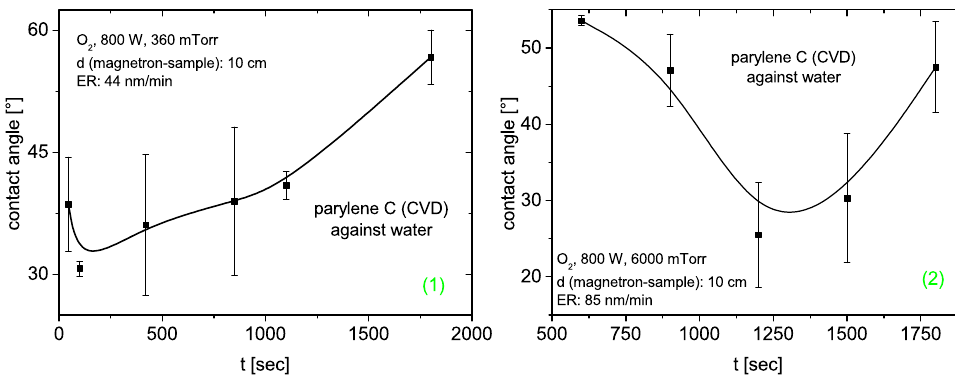
Figure 30. Contact angle of parylene C layers deposited with CVD and subsequent oxygen treatment using two different discharge pressures. ( 1 ): 360 mTorr, ( 2 ): 6000 mTorr. The conduct against water is completely altered.